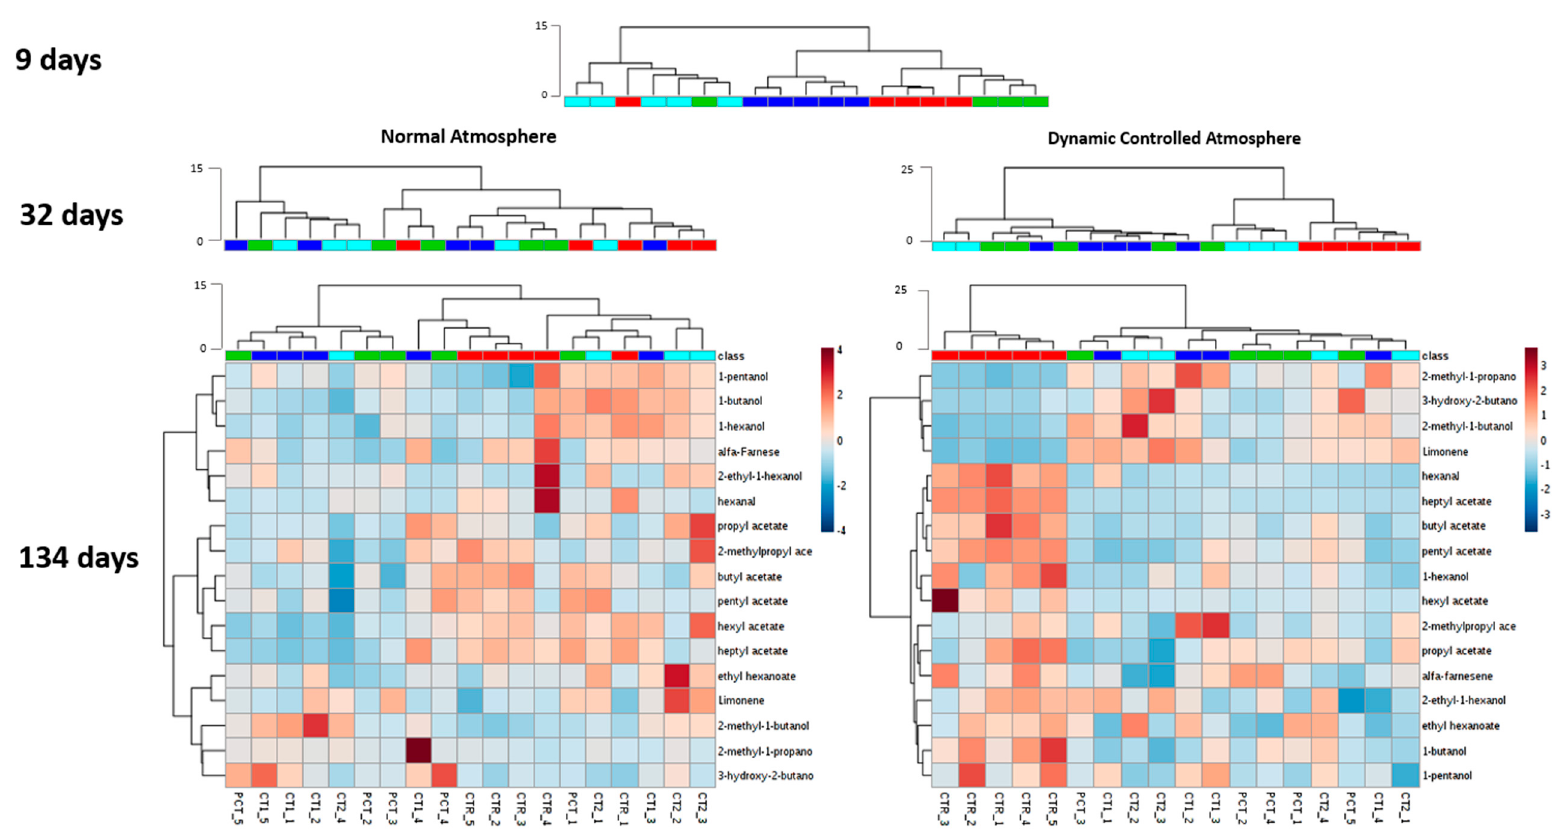
Figure 3. Dendrograms of the hierarchical clustering analysis (HCA) performed for previously reported volatile compounds of ”Rocha” pear at 9, 32, and 134 days of the assay in both normal atmosphere (NA) and dynamic controlled atmosphere (DCA) storage conditions. Euclidean distances are included on the dendrogram Y -axis. Heatmap visualization at day 134 shows the relative content of each compound, illustrated through a chromatic scale (from low (dark blue) to high chromatographic area (dark red black)), which corresponds to its peak area normalized by autoscaling. CTR (control); PCT (pectin); CT1 (coating 1); CT2 (coating 2).